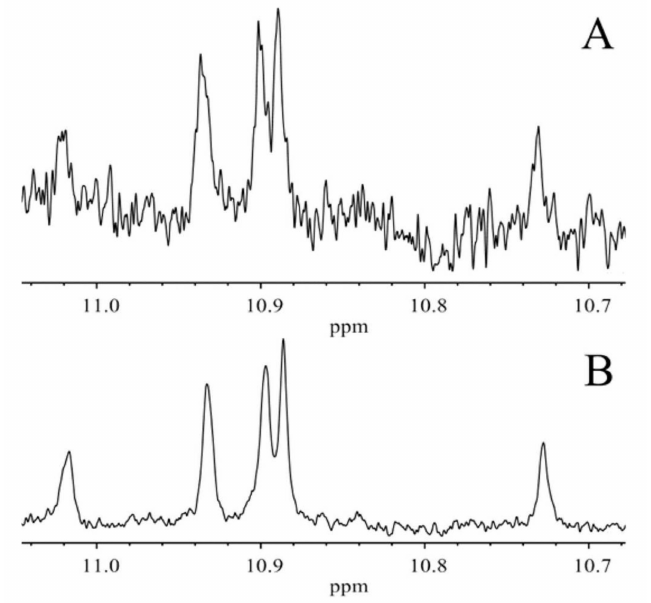
Figure 33. 1 H-NMR spectrum (700 MHz) of the hydroperoxide region of a CDCl 3 /DMSO- d 6 lipid extract prepared from a mildly oxidized mayonnaise sample. The top spectrum ( A ) is recorded with a regular excitation with a hard 90 ◦ pulse, and the bottom spectrum ( B ) was recorded with a band- selective pulse. Reprinted with permission from [135]. Copyright 2018, American Chemical